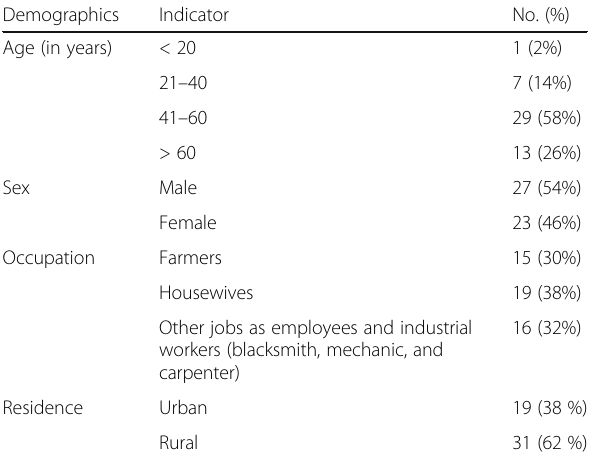
Table 1 Demographic characteristics of the studied population Demographics